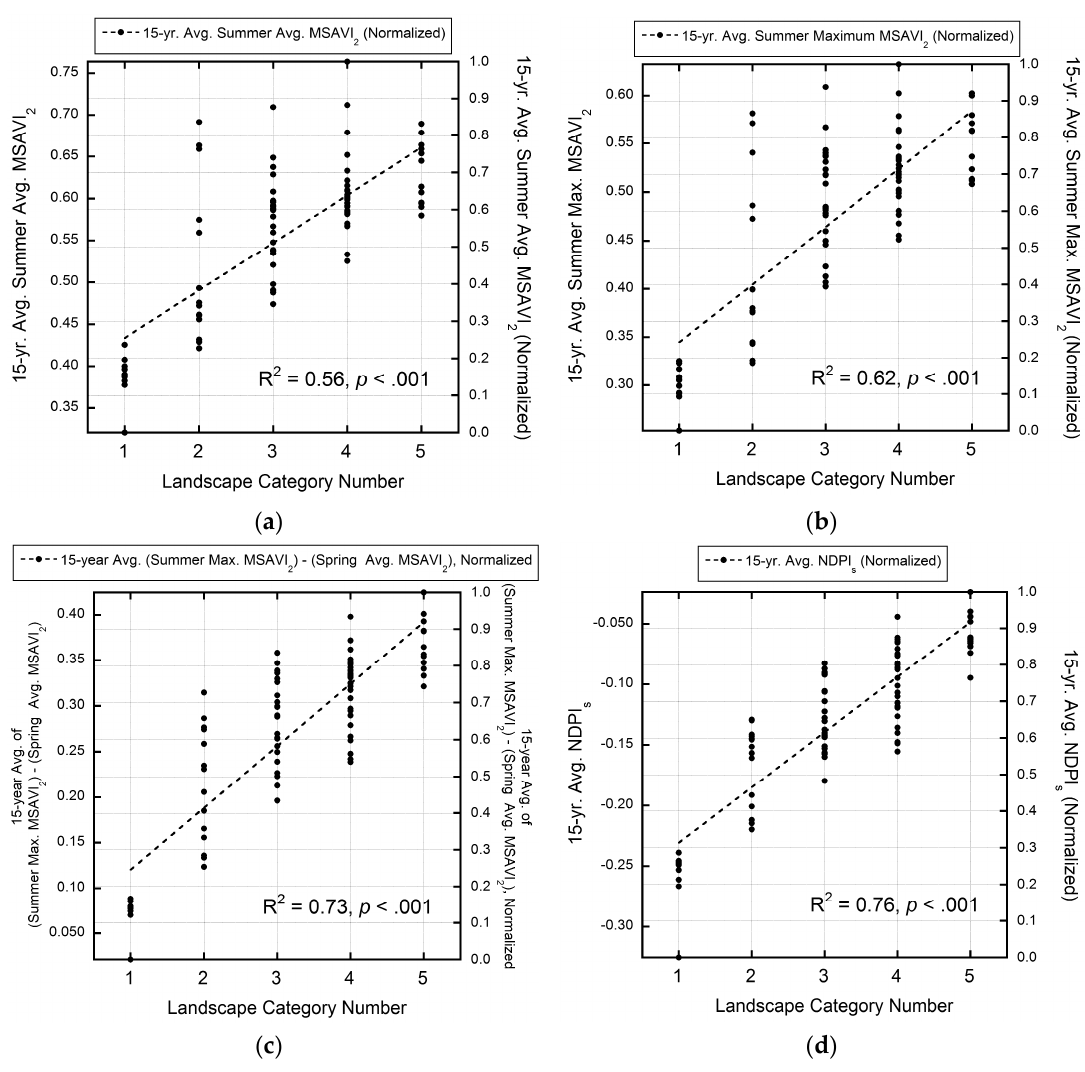
Figure 13. Relationships between raw or normalized values (left and right vertical axis, respectively) sampled at the 92 photographic survey sites and their associated landscape category for 15-year averages of ( a ) summer average MSAVI 2 ; ( b ) summer maximum MSAVI 2 ; ( c ) difference of the summer maximum MSAVI 2 and the spring average MSAVI 2 ; and ( d ) NDPI s .